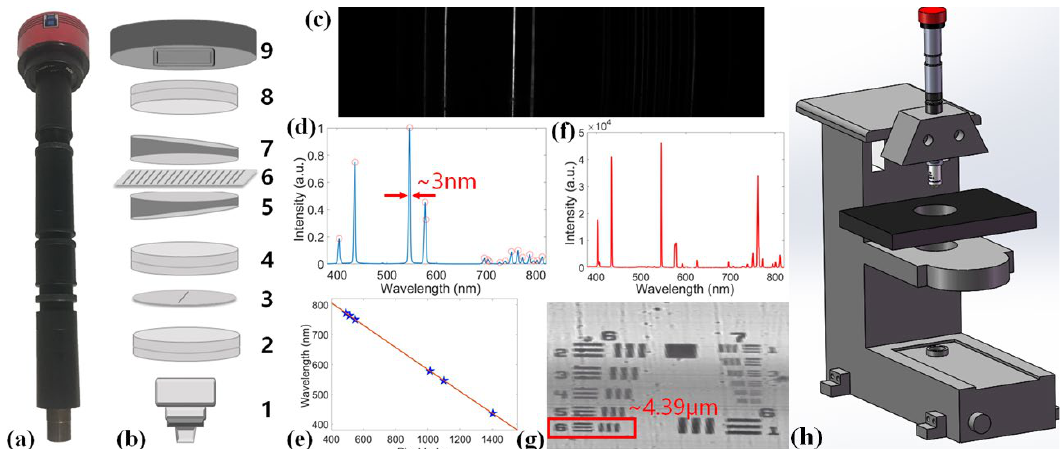
Figure 1. Schematic diagram of microscopic hyperspectral imager and the results of system calibration. ( a ) A photo of the prototype microscopic hyperspectral imager. ( b ) Schematic illustration of the optical elements: 1. Objective, 2. Imaging lens, 3. Slit, 4. Collimator lens, 5. Prism, 6. Grating, 7. Prism, 8. Tube lens, 9. CMOS (complementary metal oxide semiconductor). ( c ) Original spectral image of a calibration source. ( d ) Spectrum of the calibration source measured by our system. The spectral resolution is about 3 nm. ( e ) Calibration result between the wavelength and pixel index. ( f ) Spectrum of the calibration source measured by a commercial spectrometer. ( g ) Reconstructed hyperspectral image of the resolution test target. Resolvable lines in element 6 of group 6 (4.39 μm). ( h ) Prototype of the whole working system.